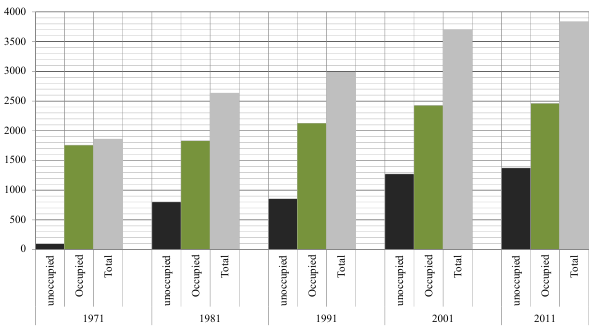
Fig. 12. Number of dwellings per type of occupation in Serra San Bruno municipality in 1971–2011 period (source: ISTAT, Italian National Institute of